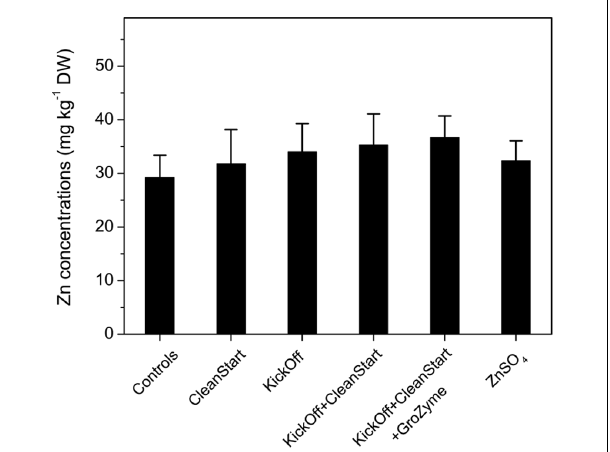
FIGURE 5 | Concentrations of Zn (mg kg –1 DW) in the petioles collected from sunflower plants treated with different foliar fertilizers. Full expanded leaves of sunflower were treated with control, CleanStart, Kick-Off, CleanStart + Kick-Off, CleanStart + Kick-Off + GroZyme, and ZnSO 4 , and the Zn concentration of leaf veins were analyzed by ICP-MS. Compositions of the nutrients in different treatments were shown in Table 1 . Data points and error bars represent means and SEs of three replicates ( n =